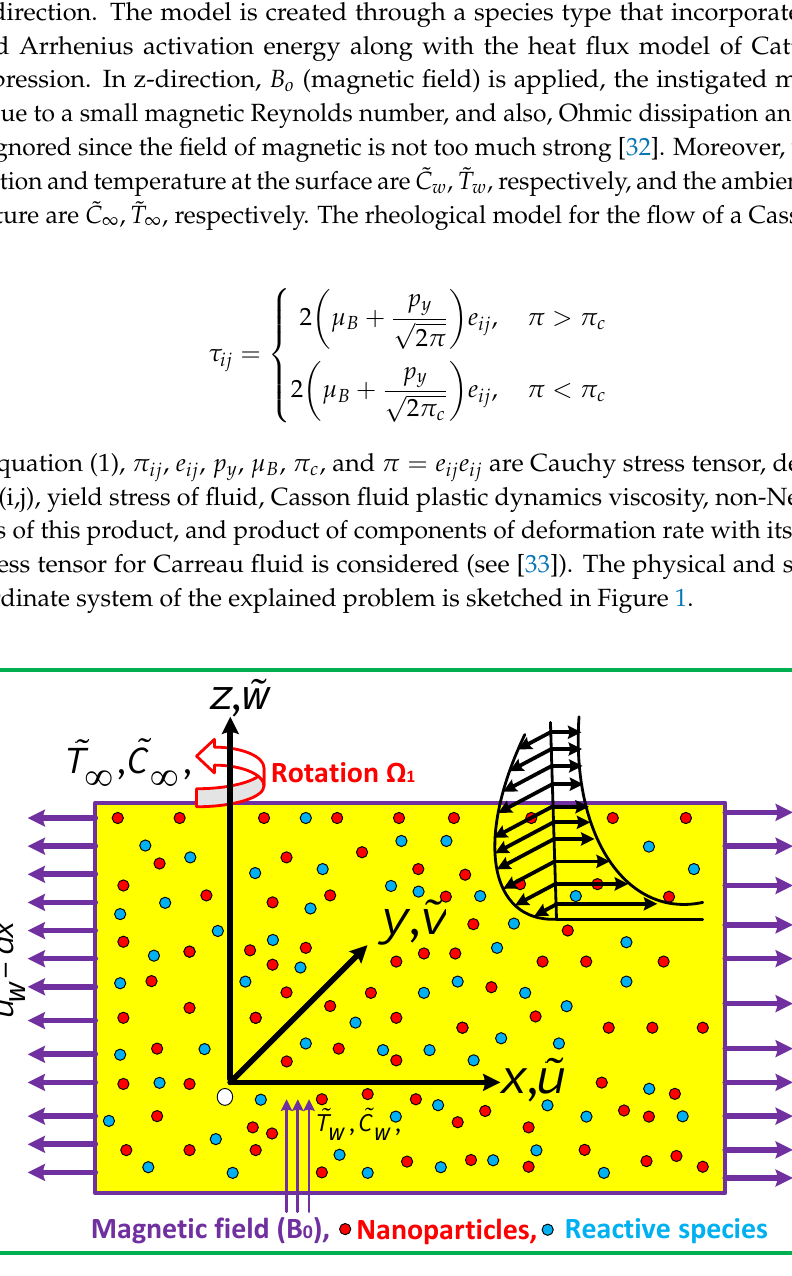
Figure 1. Schematic configuration with coordinate